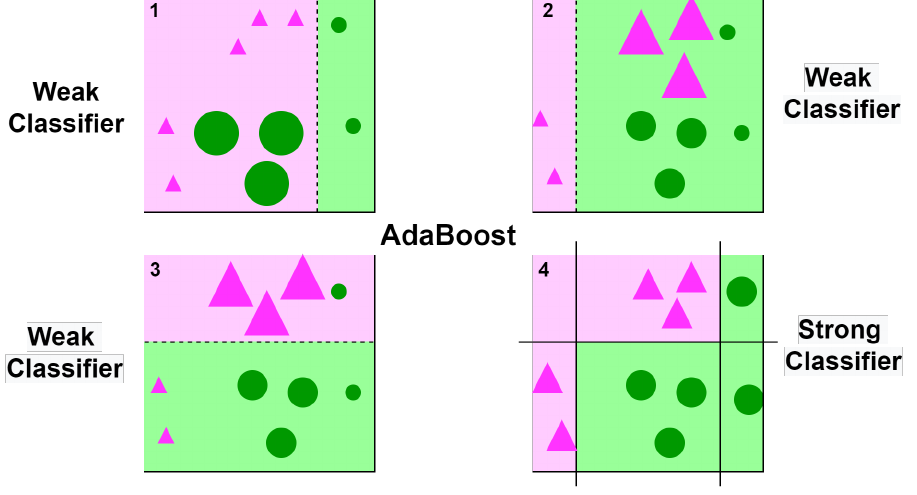
Figure 7. Working of adaptive boost